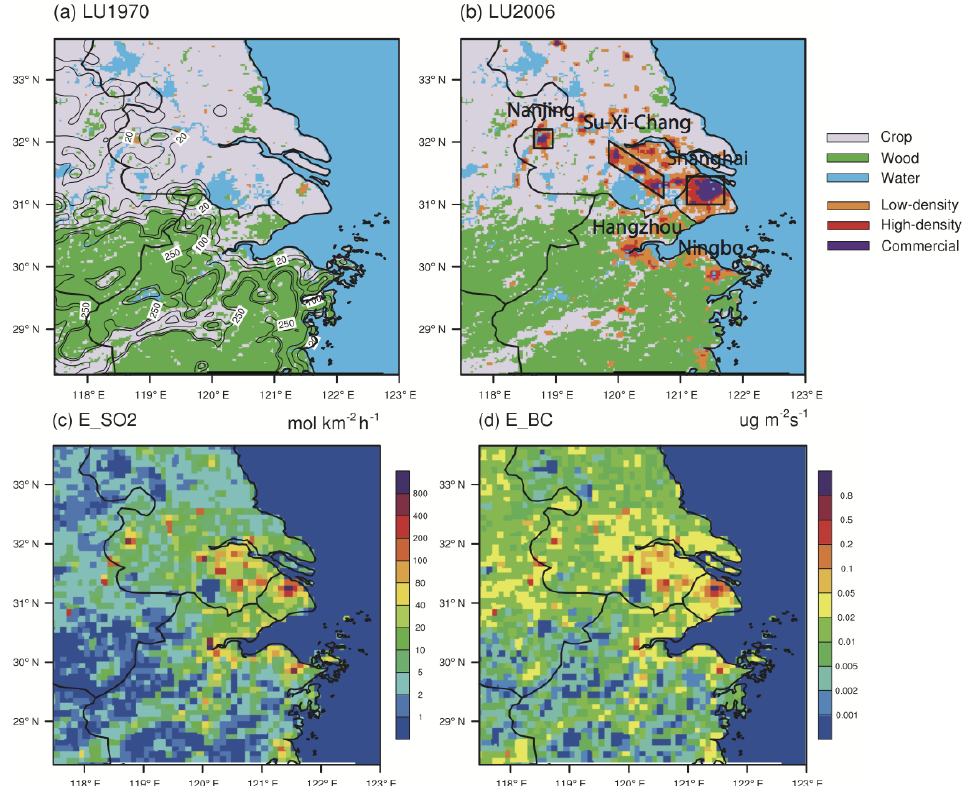
Figure 1. Land-use categories for year (a) 1970 and (b) 2006. (c) SO 2 (units: molkm − 2 h − 1 ) and (d) black carbon (BC) emission rates (units: µgm − 2 s − 1 ) averaged over 2006–2010. Surface topography is also shown in (a) (contour; units: m). The boxes in (b) outline three megacity clusters of Nanjing, Su-Xi-Chang, and